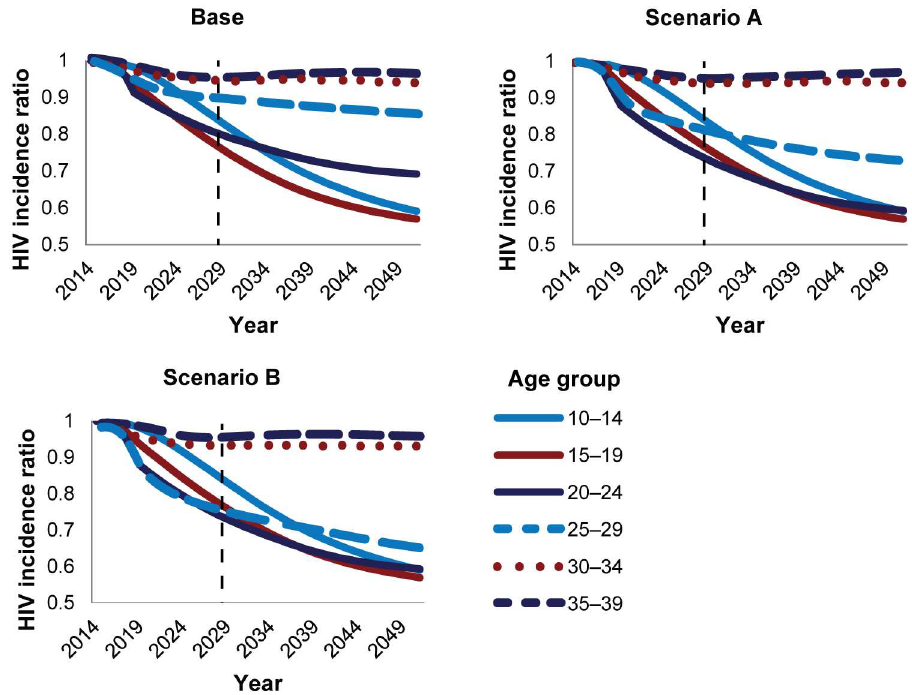
Fig 5. Modeled impact of providing VMMC to individual age groups in the various